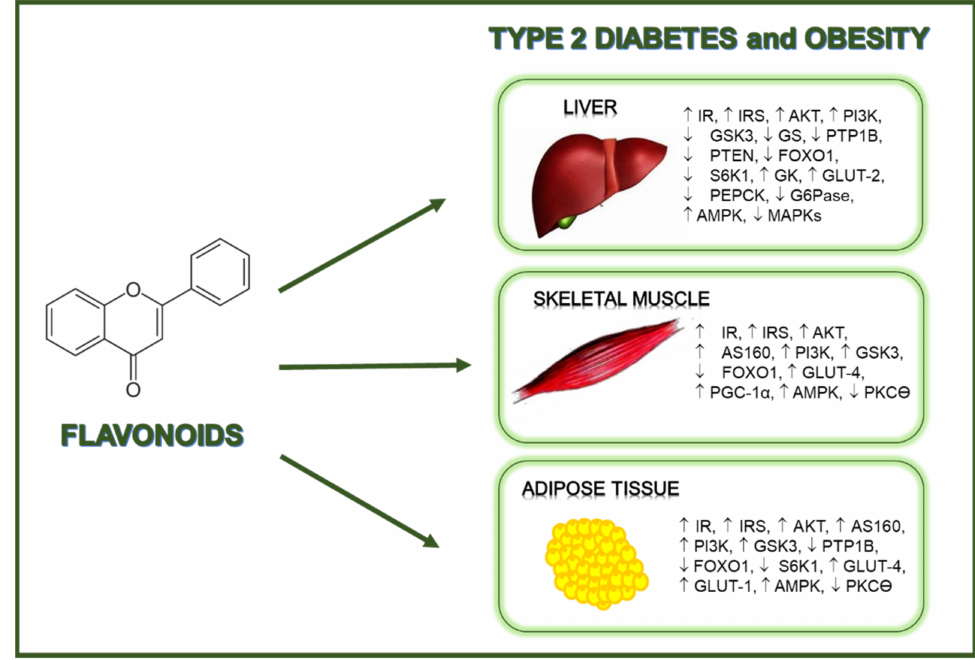
Figure 1. Flavonoids exert beneficial regulatory effects related to the prevention of diabetes and